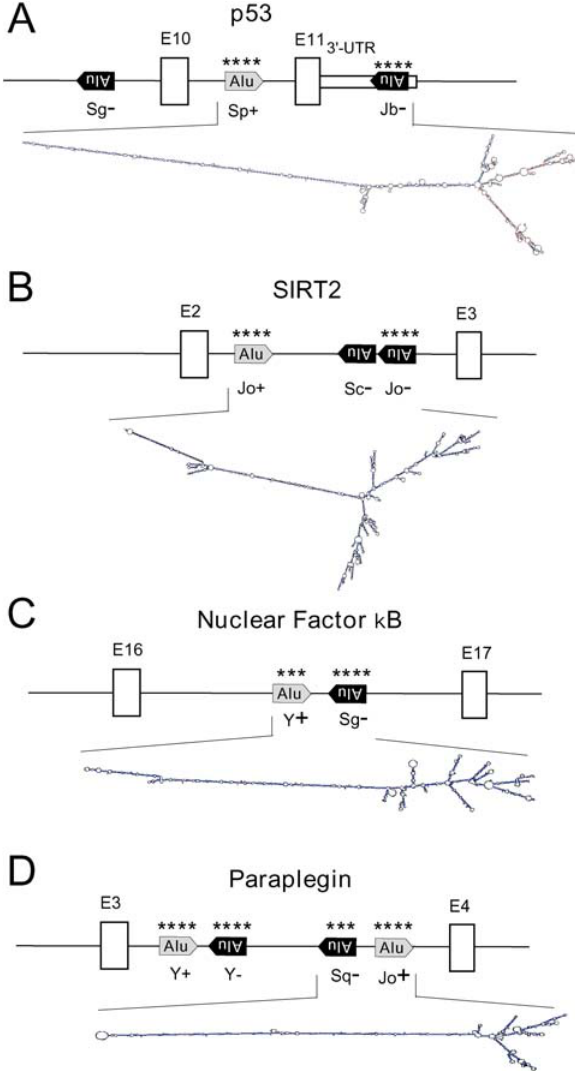
Figure 4. Alu-Mediated RNA Editing in p53, SIRT2, NF j B, and Paraplegin Pre-mRNAs Schematic presentation of the gene structures from (A) P53, (B) SIRT2, (C) NF j B, and (D) SPG7. Edited repeat elements are marked by asterisks. RNA folds appear as calculated with MFOLD. The AluJb (cid:1) in p53 is located in the 3 9 -UTR (A); all others are intronic. *, editing sites. DOI: